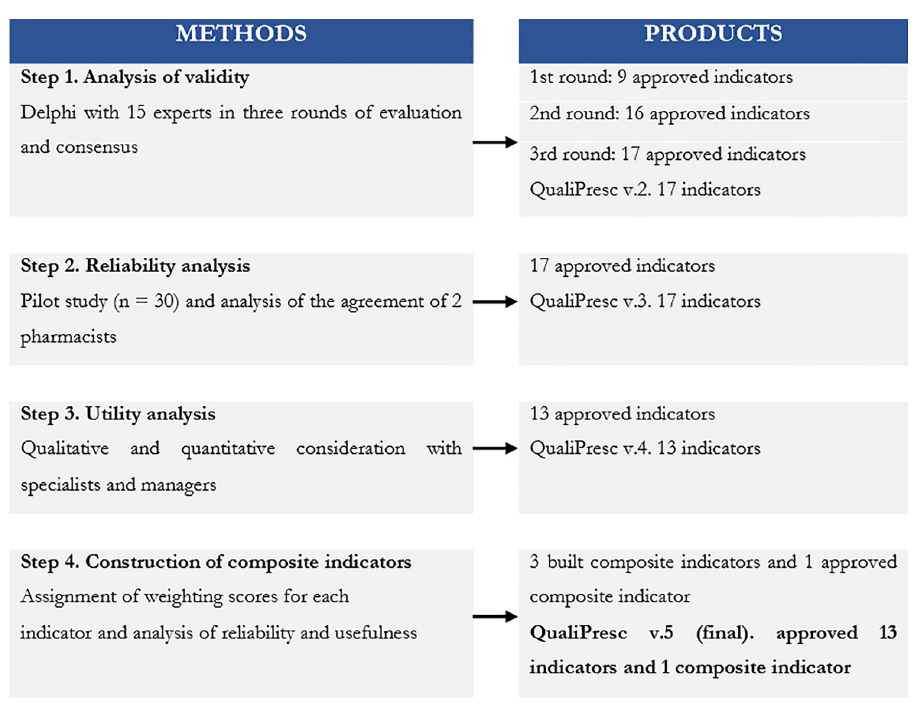
Fig 1. Flow of steps and products for the development and validation of the